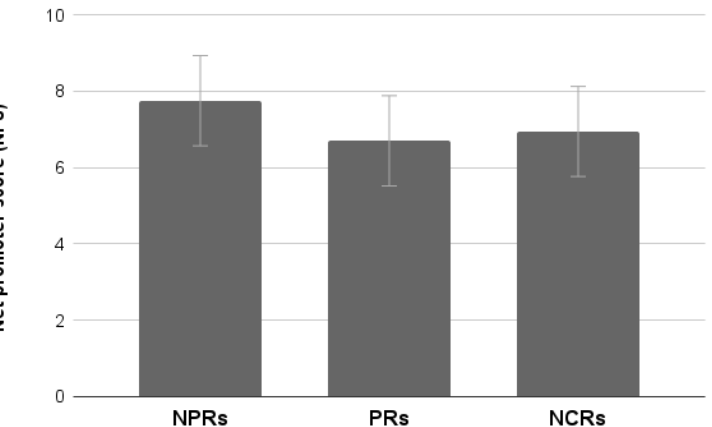
Figure 14. NPS scale score by Group (NPRs vs. PRs vs. NCRs). Error bars denote 0.95 confidence intervals.